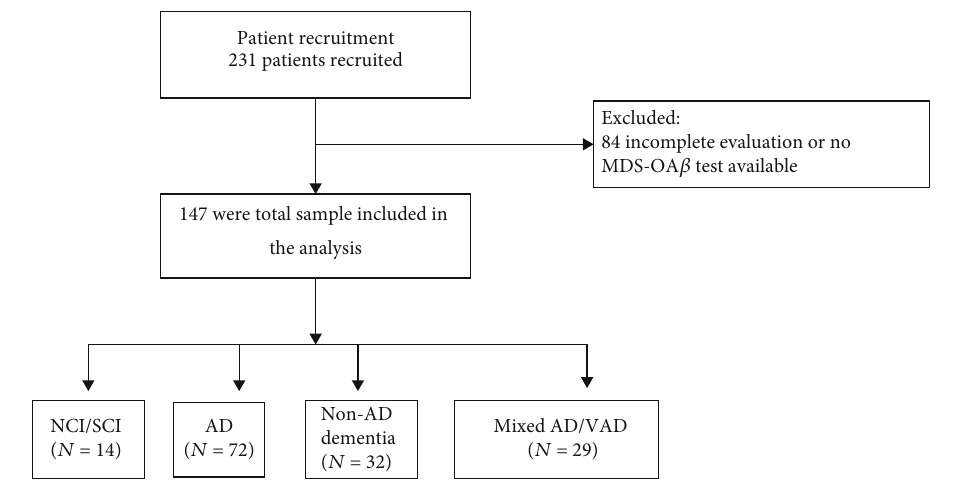
Figure 1: Study fl